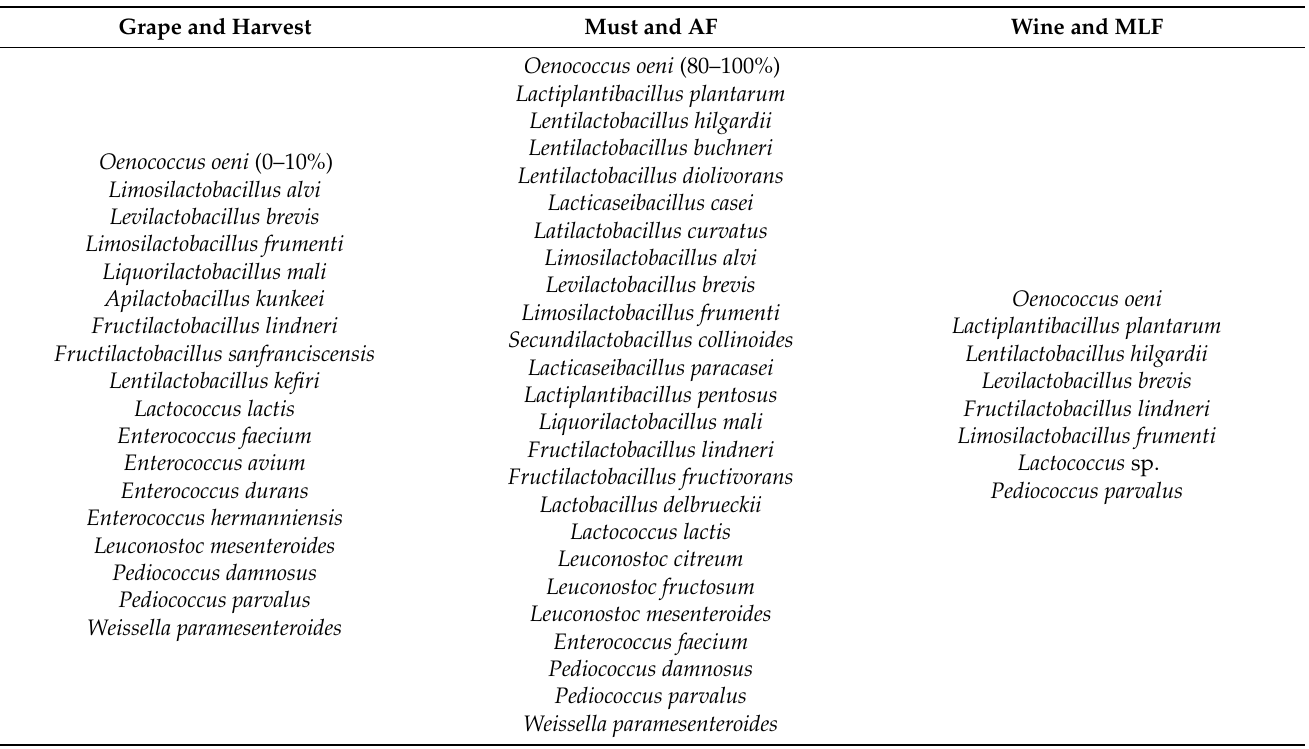
Table 1. Species of selected lactic acid bacteria found in association with raw materials in representative phases of winemaking (grape harvest, must alcoholic fermentation, wine malolactic fermentation), according to selected studies [20–25]. Grape and Harvest Must and AF Wine and